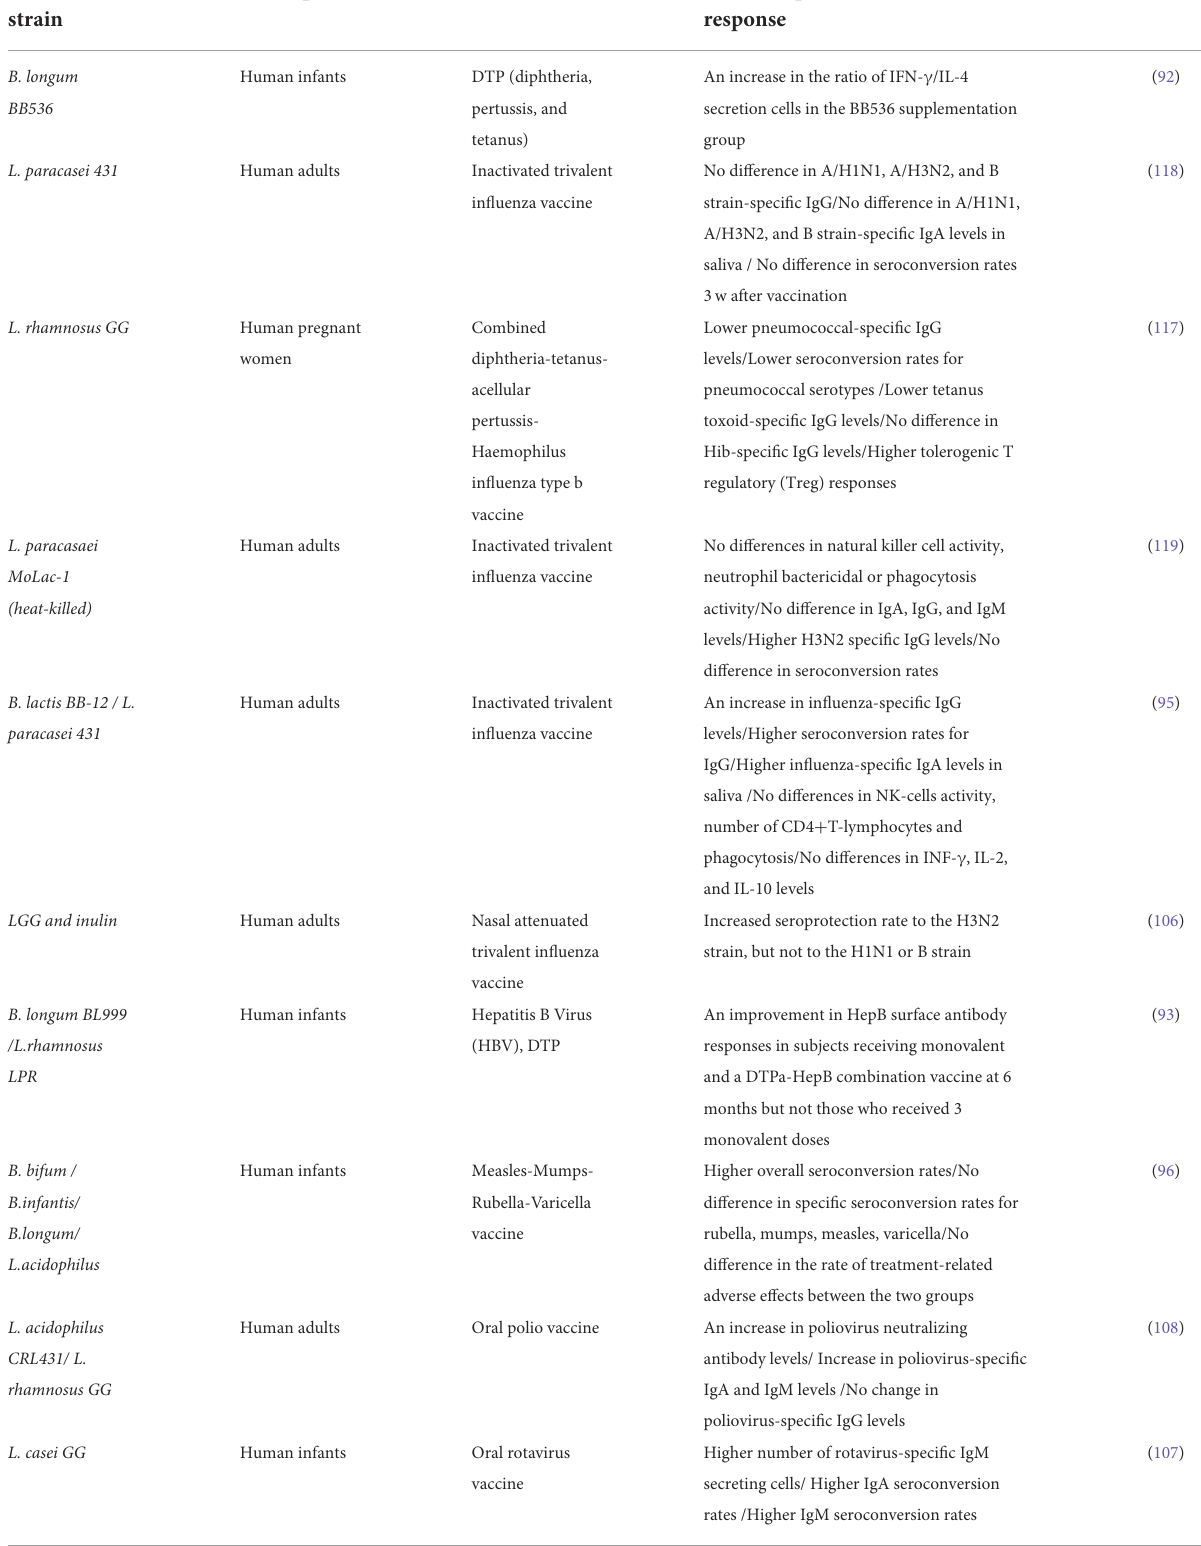
TABLE 1 Probiotics’ effect on immune responses and vaccine efficacy.